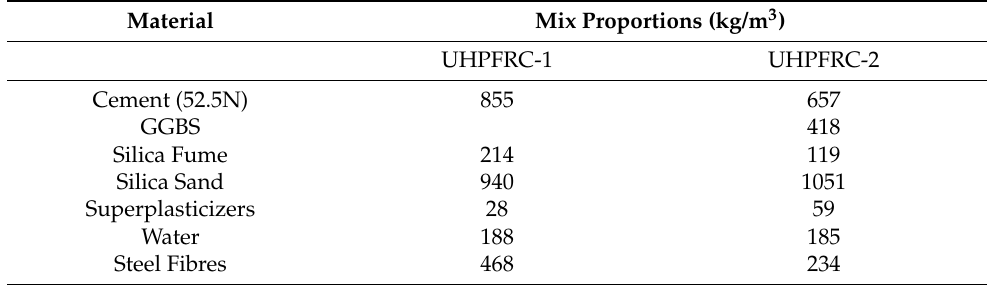
Table 1. UHPFRC 1 and 2 mix